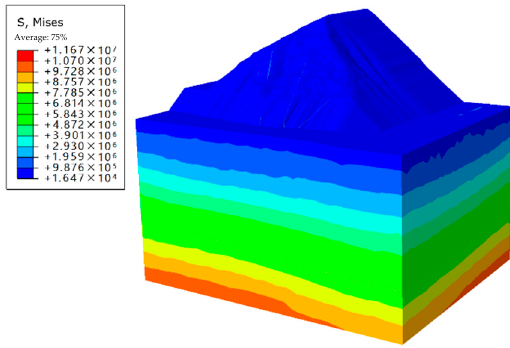
Figure 10. Initial ground stress distribution.